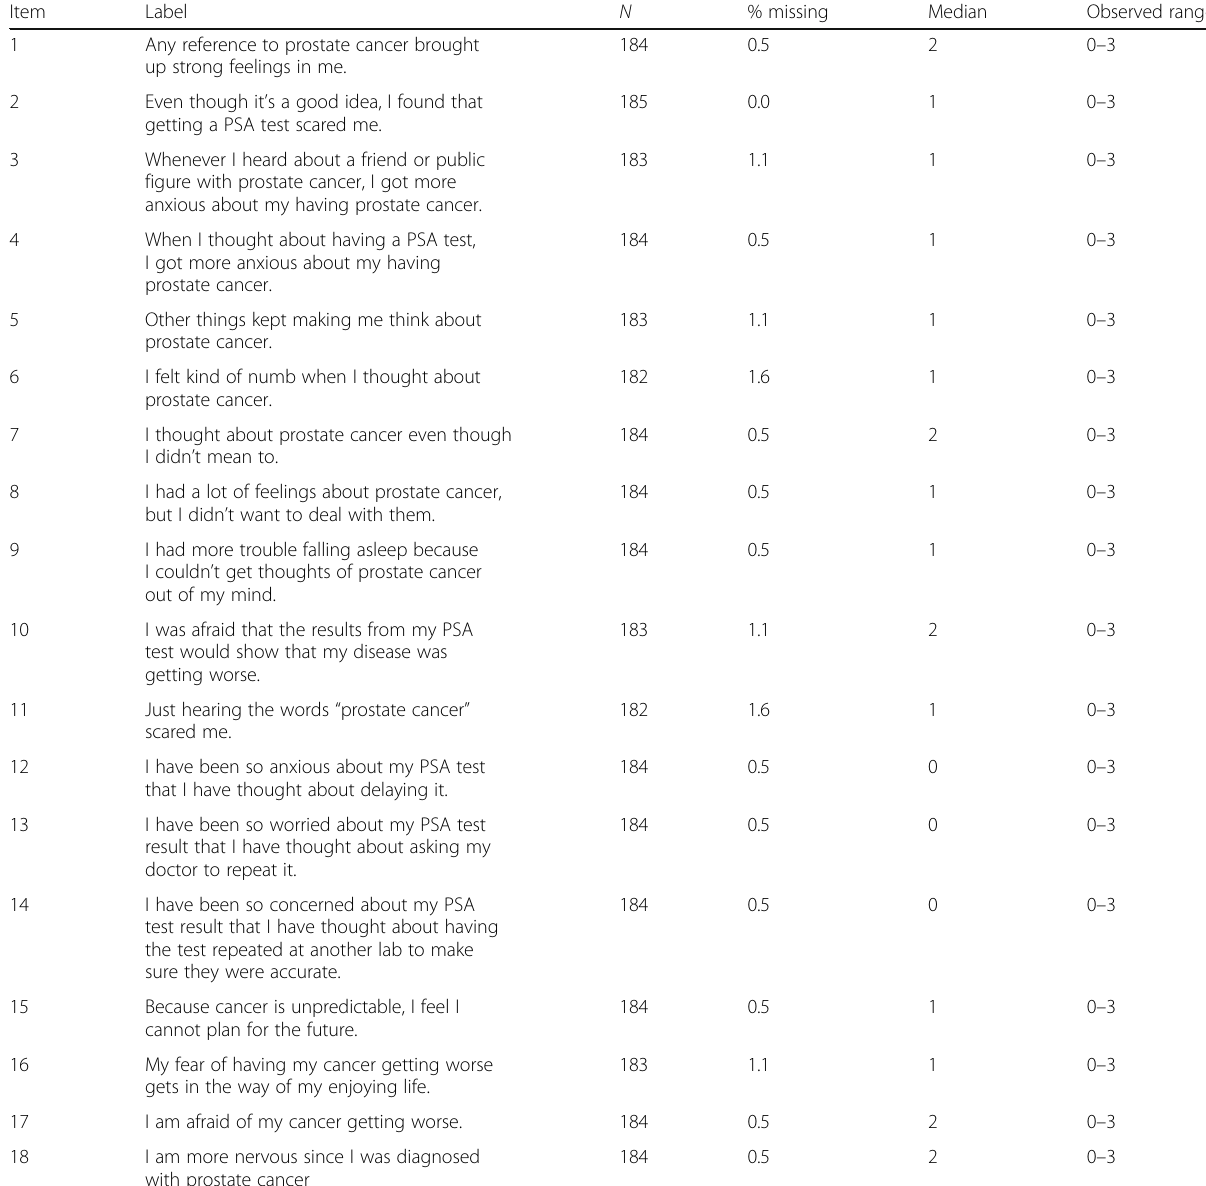
Table 1 Descriptive statistics for each item on the MAX-PC ( N = 185)